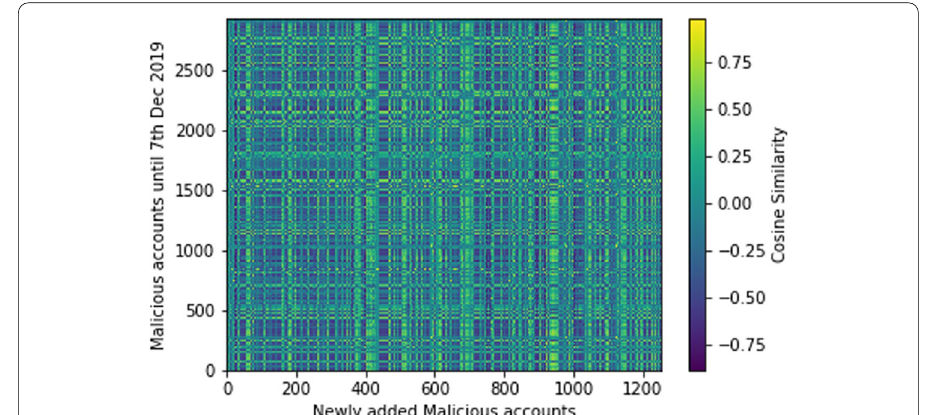
Fig. 9 Cosine similarity between malicious accounts identified on different dates